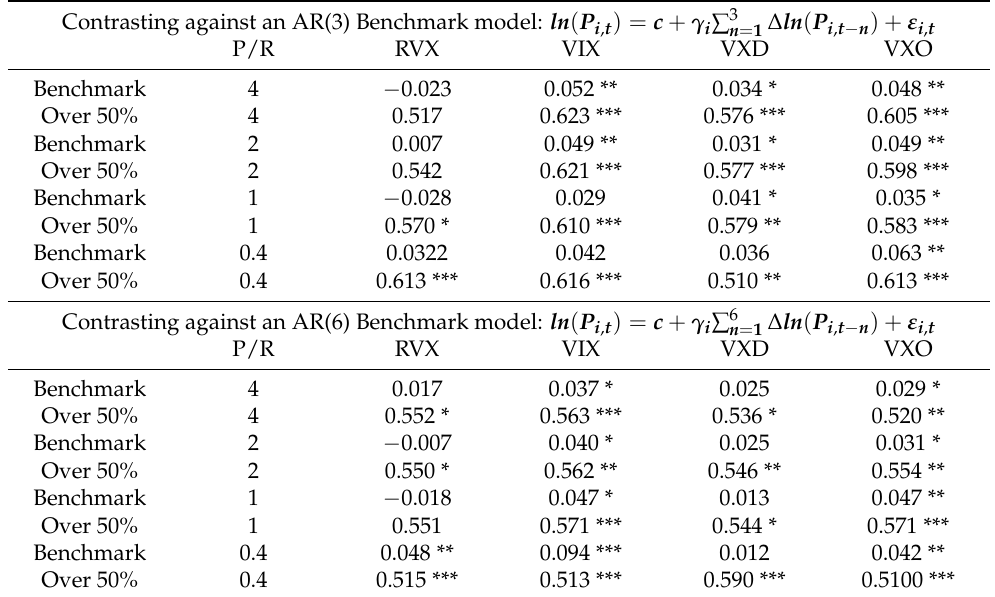
Table 6. Mean Directional Accuracy when Forecasting stock market implied volatility with financial reports tone